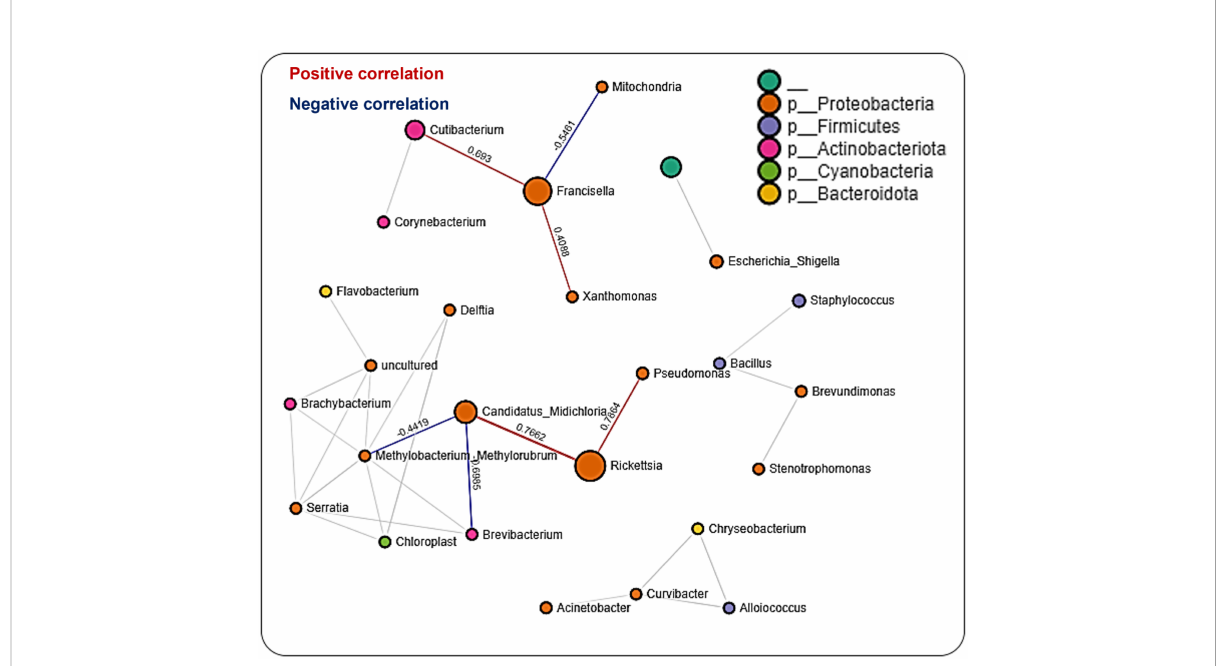
FIGURE 7 Correlation network analysis in the midgut of Am. maculatum ticks. Correlation network generated using the SparCC algorithm. Correlation network with nodes representing taxa at the family level and edges representing correlations between taxa pairs. Node size correlates with the number of interactions in which a taxon is involved, and the line color represents either positive (red) or negative (blue) correlations. The color- coded legend shows the bacterial family to which each taxon